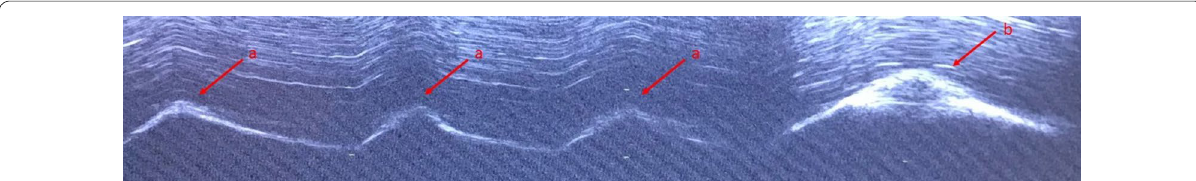
Fig. 3 M-mode ultrasonography demonstrating three tidal inspiratory efforts ( a ) and a deep inspiratory effort ( b )